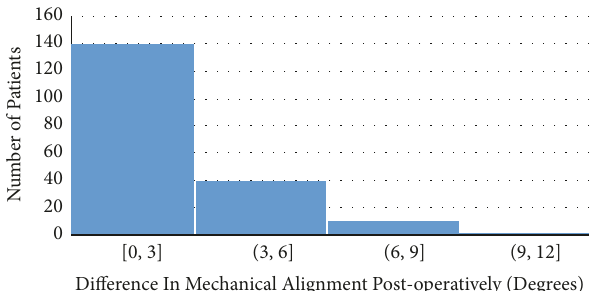
Figure 3: Categorized distribution of difference in mechanical alignment of navigation and scanogram